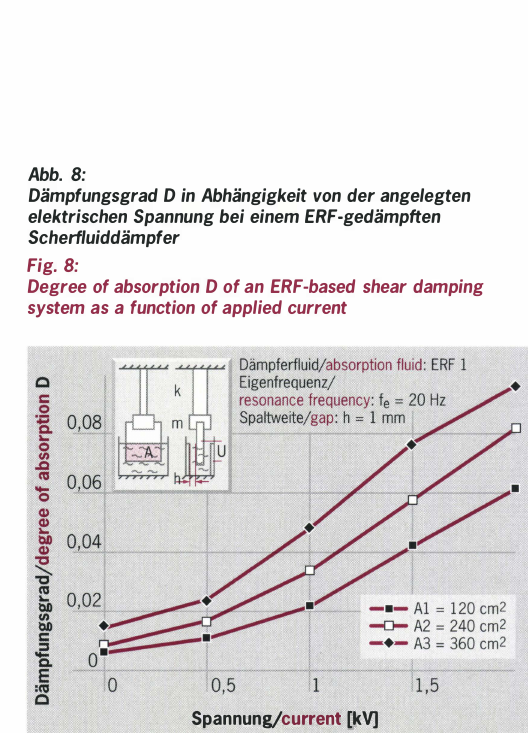
Spannungjcurrent